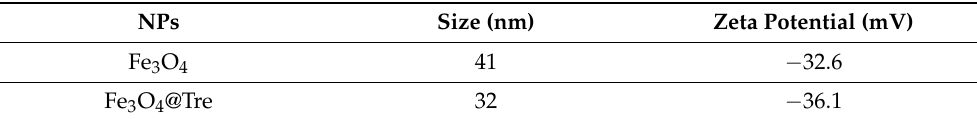
Table 1. Zeta potential and hydrodynamic size of Fe 3 O 4 and Fe 3 O 4 @Tre NPs in 100 mM PBS with pH = 7.4.